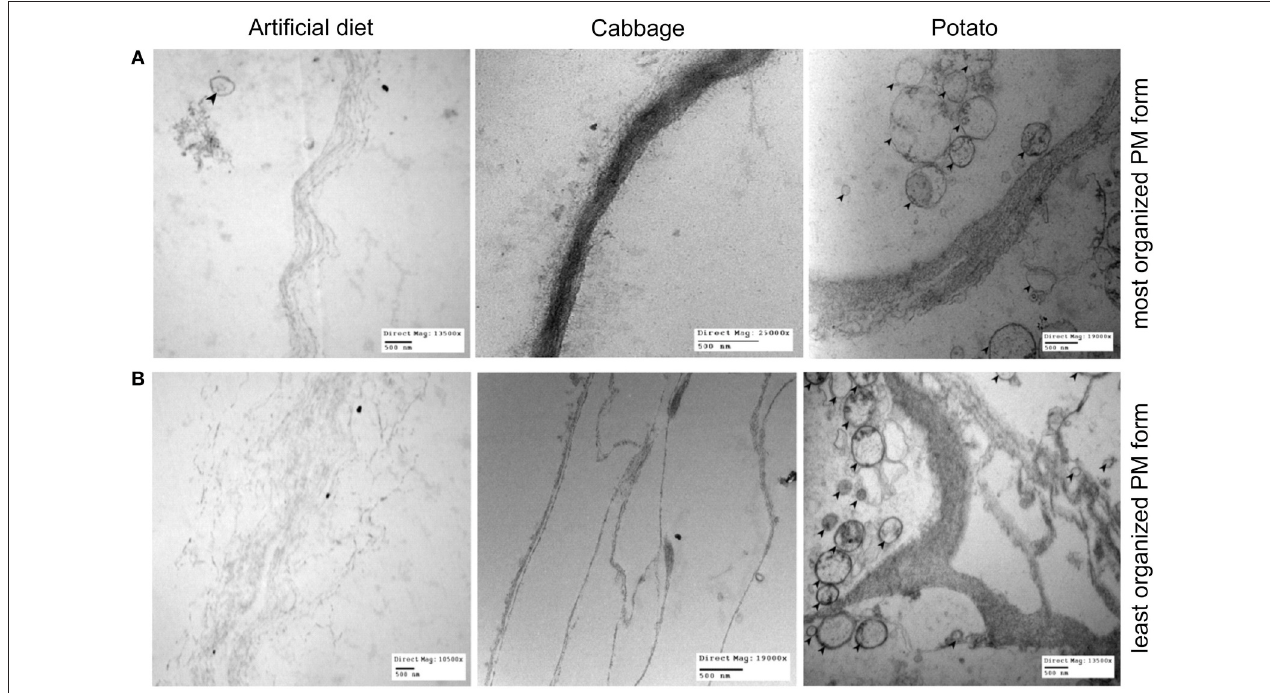
FIGURE 4 | The range of PM morphology observed in 4th instar T. ni larvae raised on 3 different diets: artificial diet, cabbage, and potato. (A) Depicts an example of the most organized appearance of the PM for each diet and (B) depicts an example of the least organized. Note the bends/kinks present in the example of PM of potato-fed larvae at its least organized (bottom right image). Left column: larvae raised on artificial diet (top image magnification = 13,500 × ; bottom image magnification = 10,500 × ). Middle column: larvae raised on cabbage (top image magnification = 25,000 × ; bottom image magnification = 19,000 × ). Right column: larvae raised on potato (top image magnification = 10,500 × ; bottom image magnification = 13,500 × ). Bars = 500nm. Black arrows point to microvesicles, which are present significantly more in potato-fed larval PMs regardless of the level of organization.